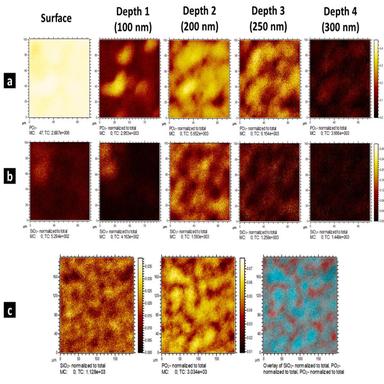
ToF-SIMS distribution image of PO2 - (a) and SiO2 - (b) at the different depths and their overlay in a larger area (c)